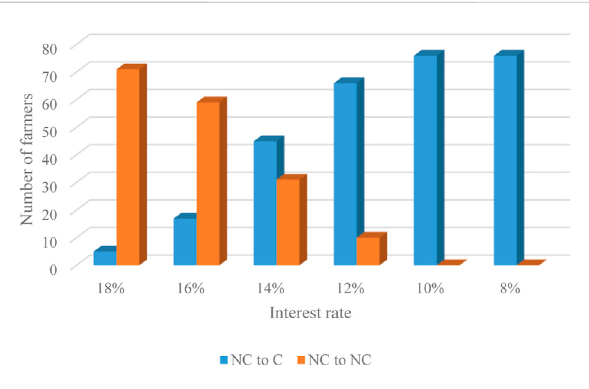
FIGURE 8 Analysis of the behavior of non-cooperative farmers with S1